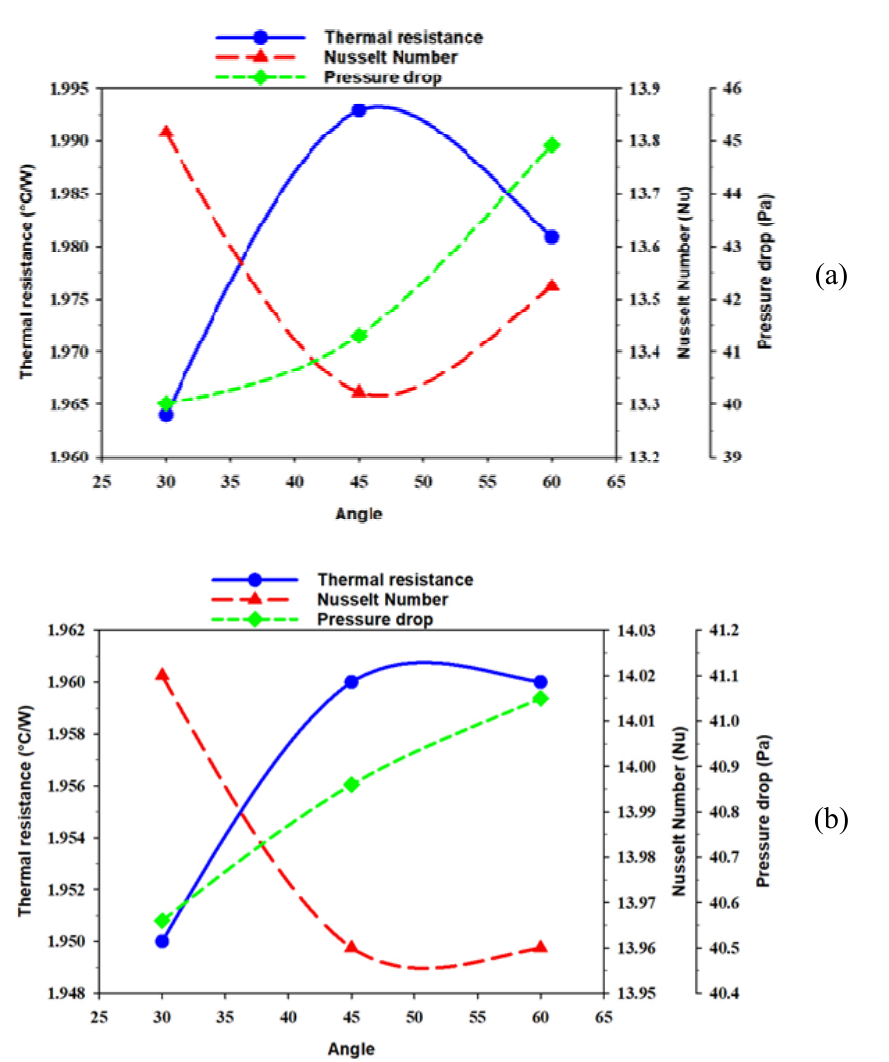
Figure 5. Effect of attack angle on thermo-hydraulic behavior for ( a ) delta winglet shaped vortex generator and ( b ) protrusion shaped vortex generator.